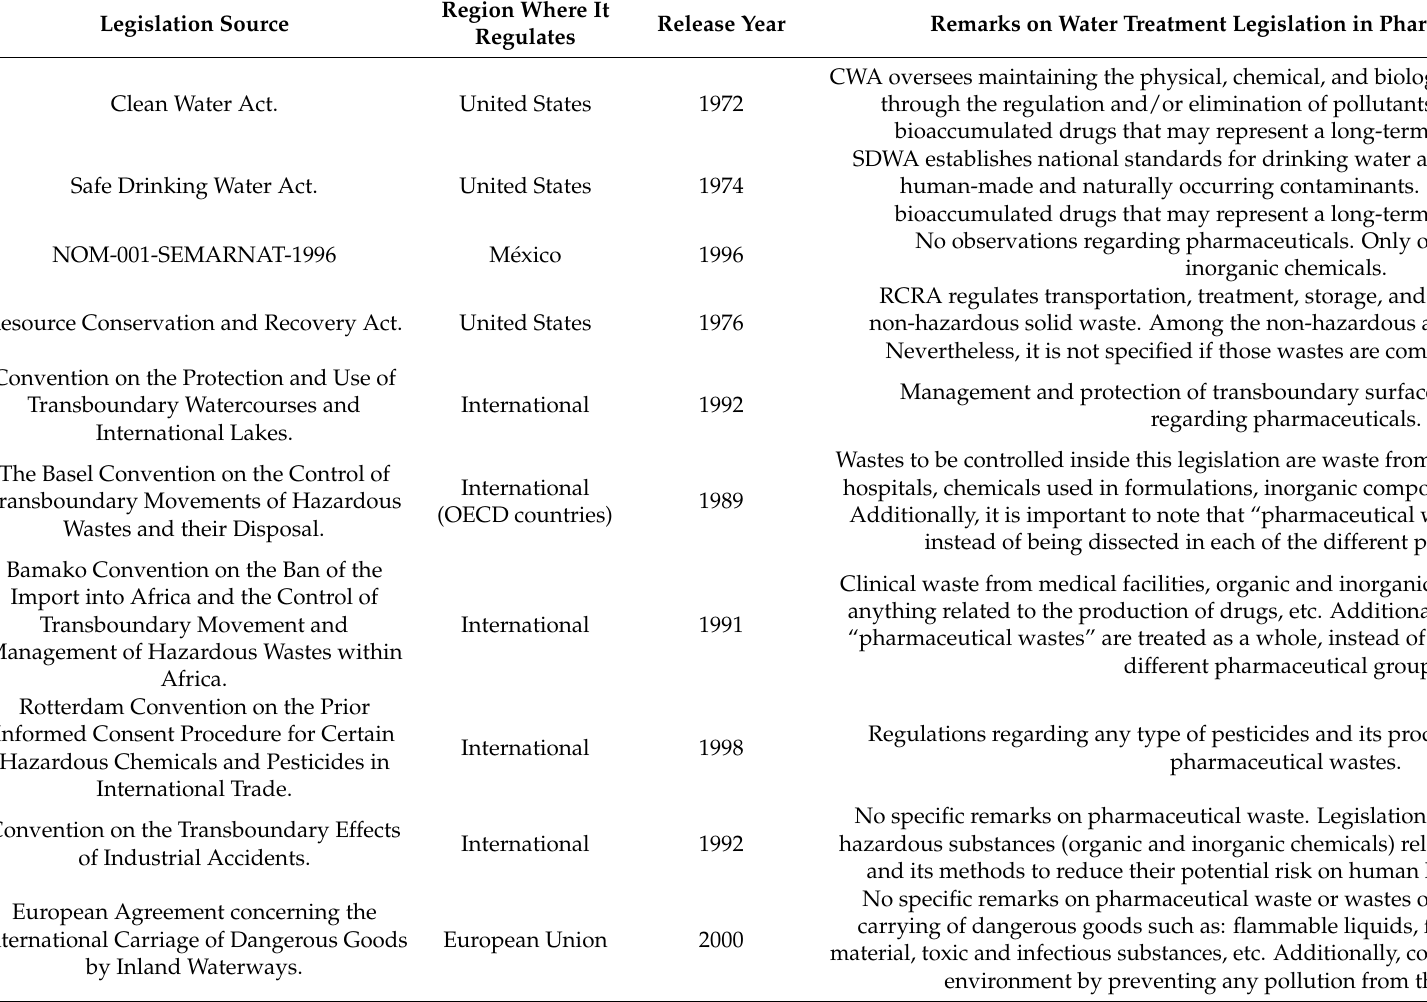
Table 6. Wastewater most well know regulations and their pharmaceutical